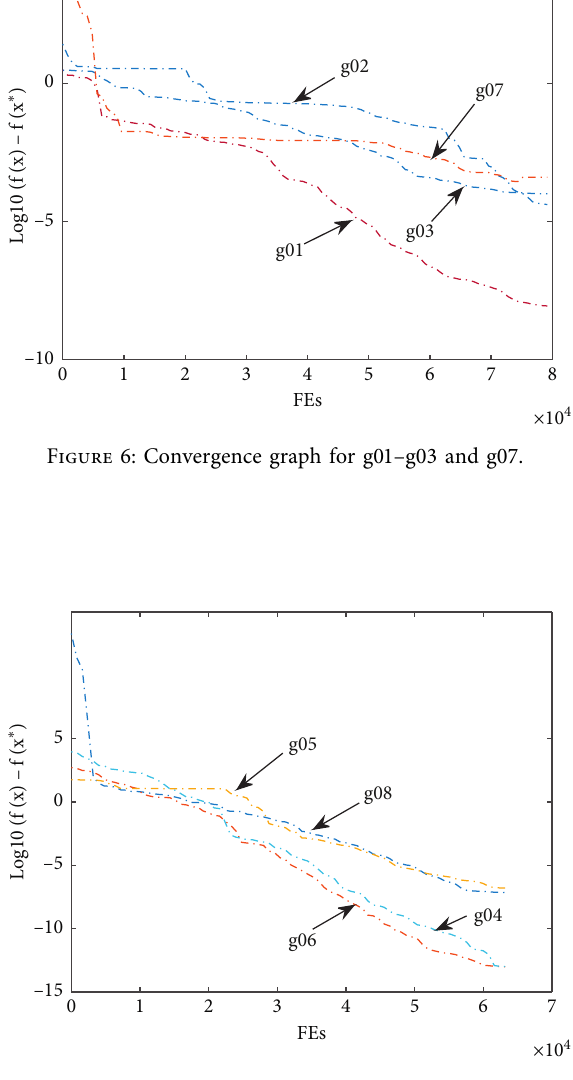
Figure 7: Convergence graph for g04–g06 and